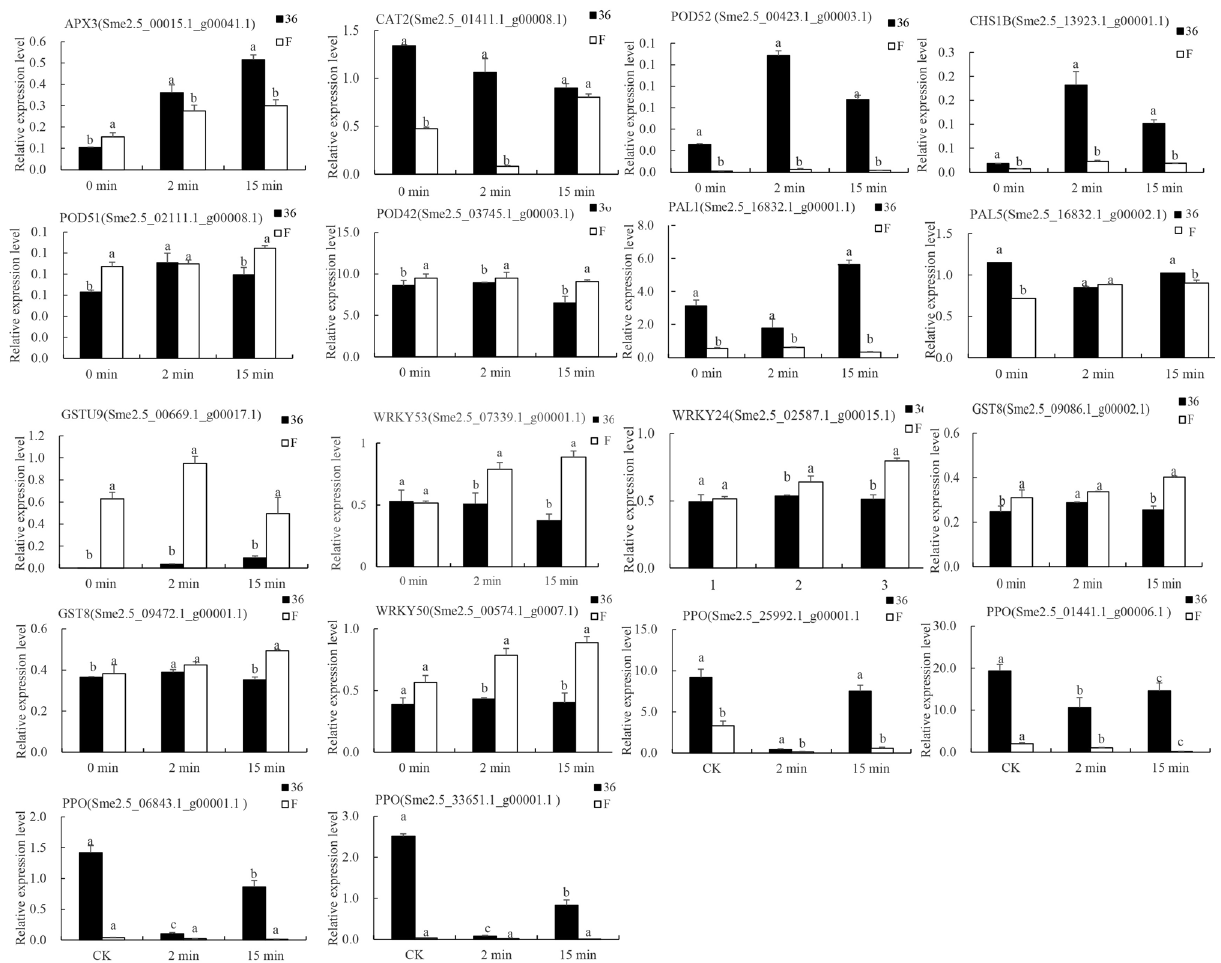
Figure 11. qRT-PCR of the expression levels of 18 browning-related genes. The error bars represent the standard error of three biological replicates. PKG was used as the internal